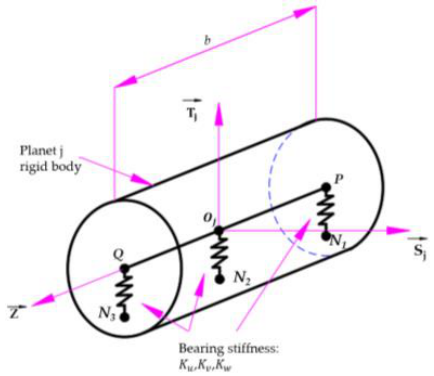
Figure 3. Planet bearing element.